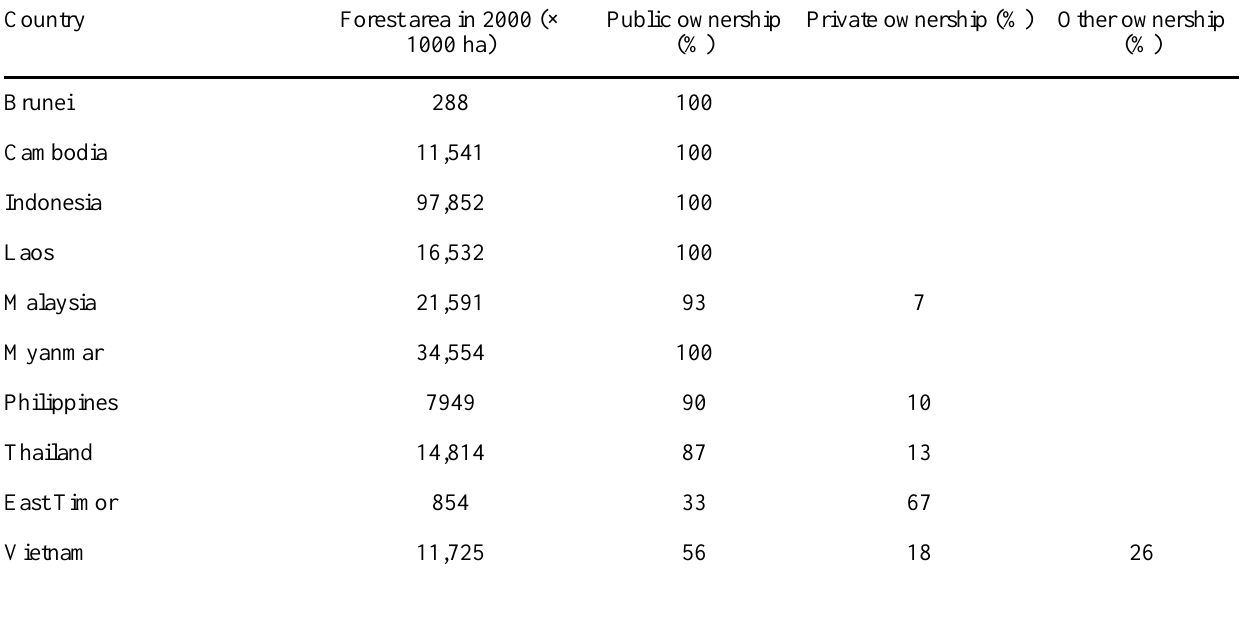
Table 2. Ownership of production forests in Southeast Asia. Source: Food and Agriculture Organization